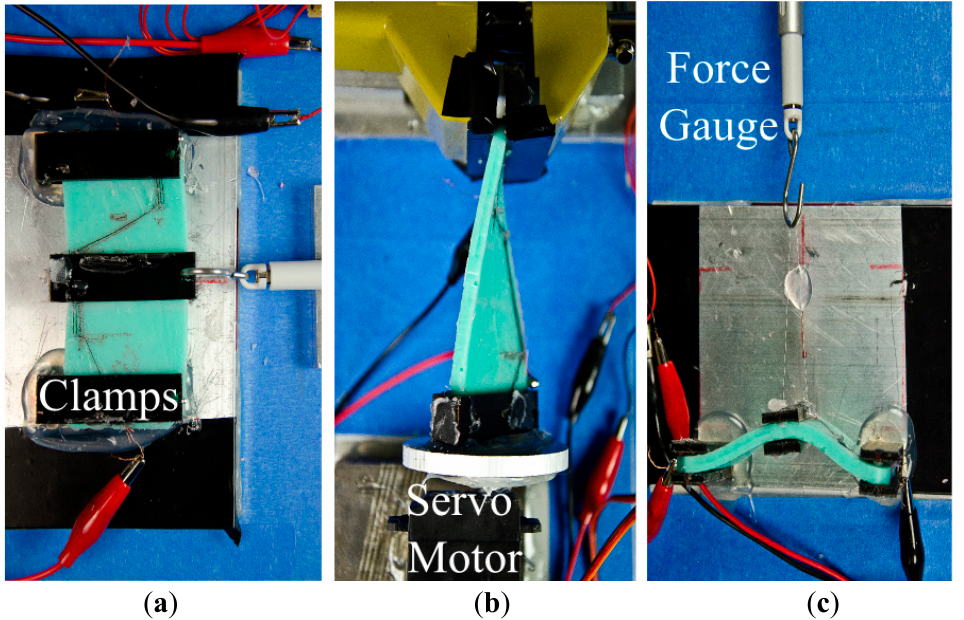
Figure 6. Experimental setups which generate deformations for ( a ) bending; ( b ) twisting and ( c )